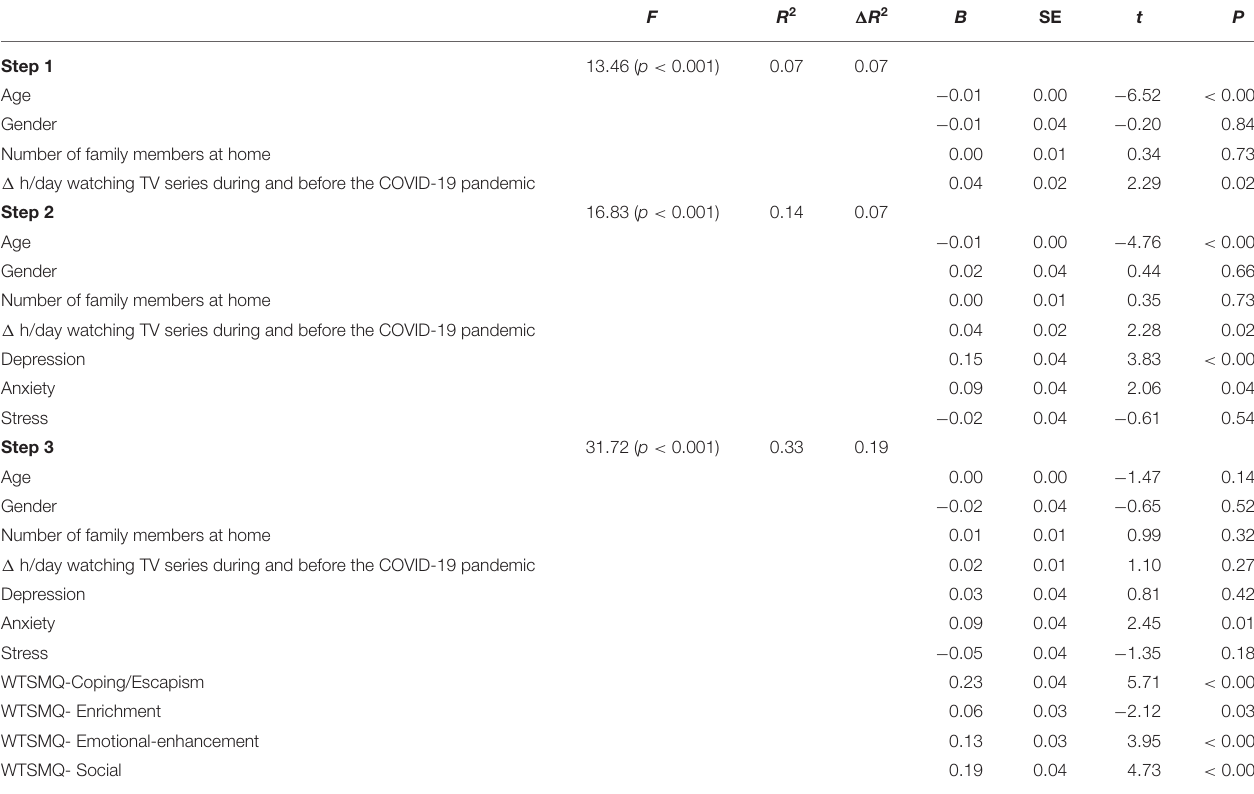
TABLE 4 | Regression: predictors of loss of control over TV series watching during the COVID-19